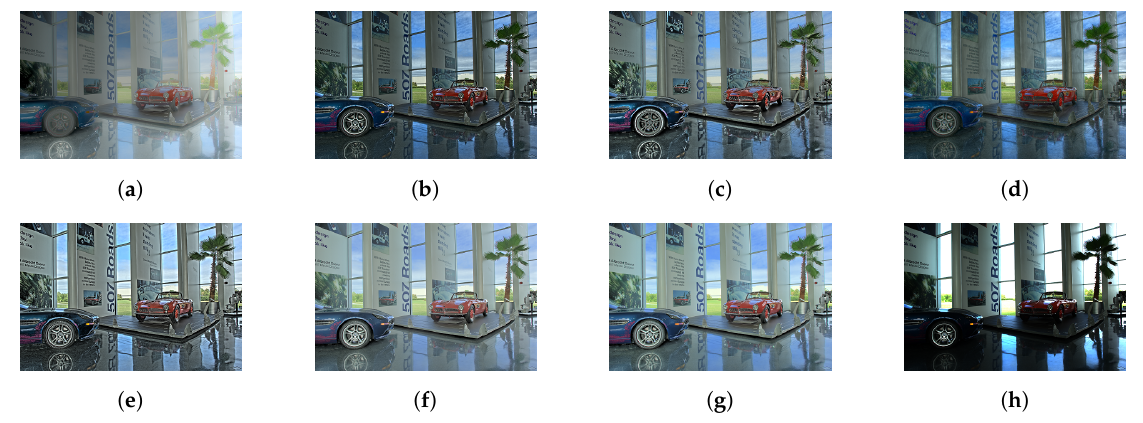
Figure 9. Comparison of tone-mapping methods. ( a ) LW [6], ( b ) WLS [28], ( c ) RoG [2], ( d ) L0 [50],